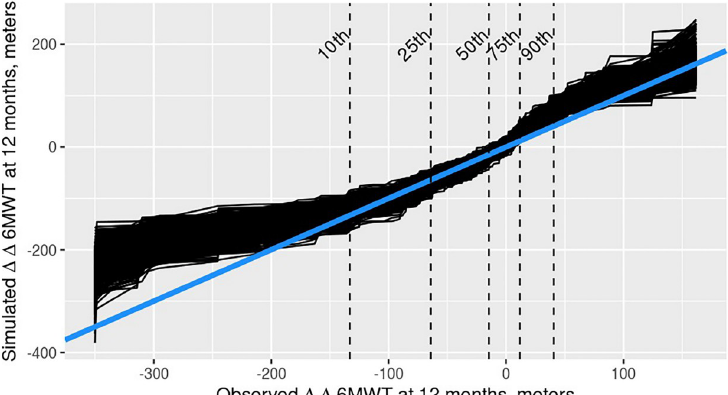
Fig 6. Predictive check quantile-quantile plot for the natural history model fit to a subset of subjects with baseline ages between 7–13 years. The simulated 6-minute walk test (6MWT) change from baseline (CFB) is plotted against the observed 6MWT CFB from 500 Monte Carlo simulations. The 10th, 25th, 50th, 75th and 90th quantiles of the observed 6MWT CFB distribution are shown with dashed lines. The blue line indicates the line of identity.